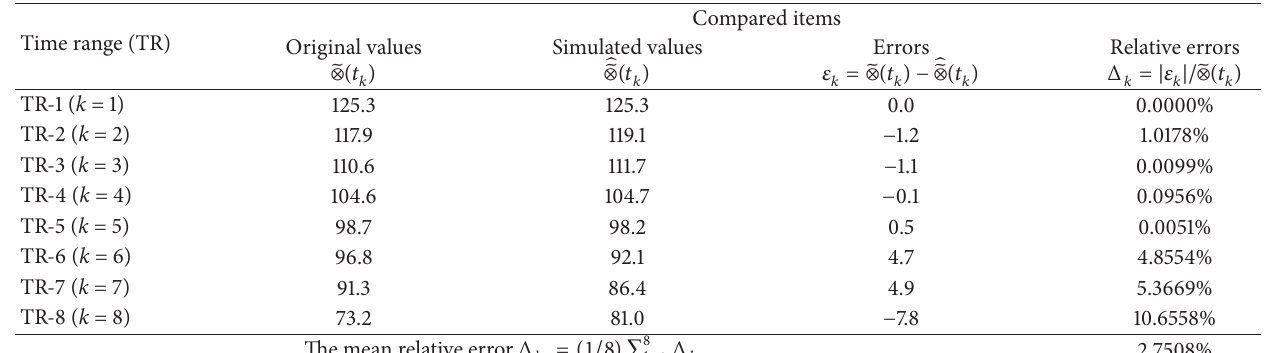
Table 4: Simulated values and errors of kernels.